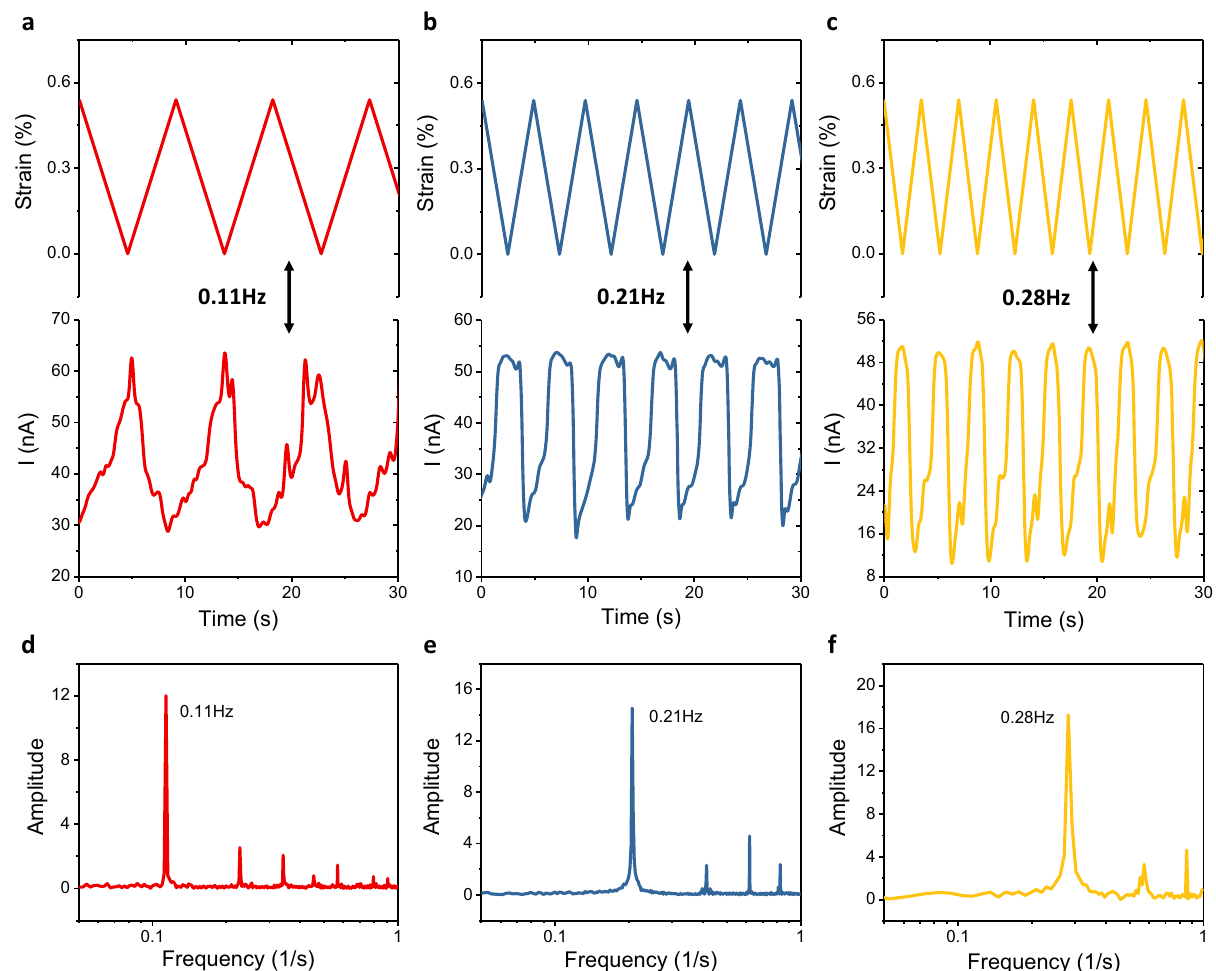
Fig. 5 Dynamic strain sensing of SnS 2 based strain sensors working under illumination. a – c The top row shows dynamic strain applied to a sensor at three different frequencies: a 0.11 Hz, b 0.21 Hz and c 0.28 Hz. The second row shows the current response corresponding to each dynamic strain state. d – f The bottom row shows frequencies calculated by Fourier transforms of I – t curve in fi gure ( a – c)